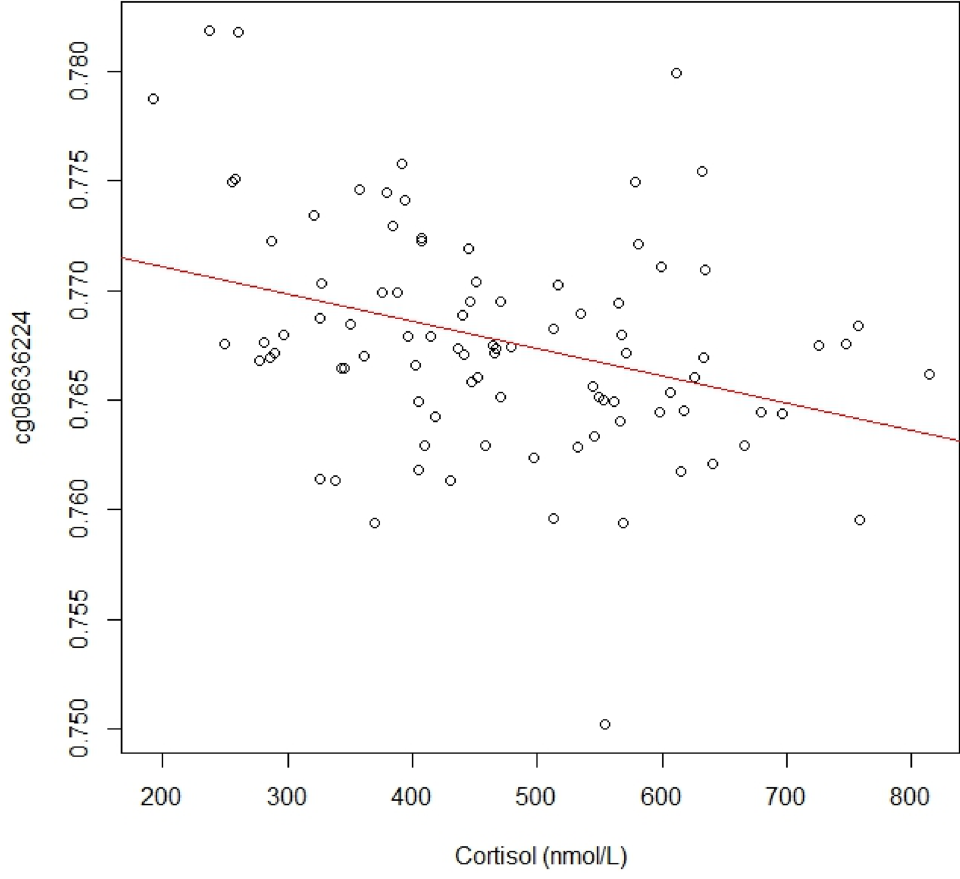
Figure 1. Scatterplot of FKBP5 associated CpG site cg08636224 methylation levels and baseline cortisol (nmol/L).